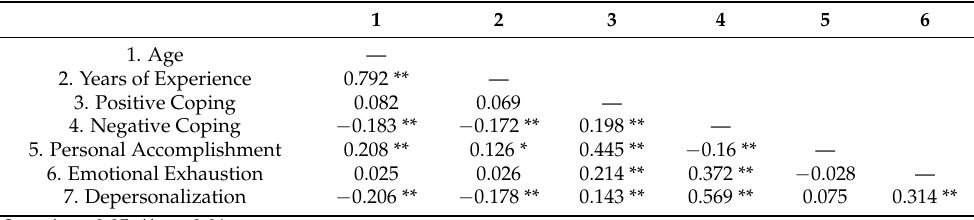
Table A1. SD’s above and below the mean. N = 346.